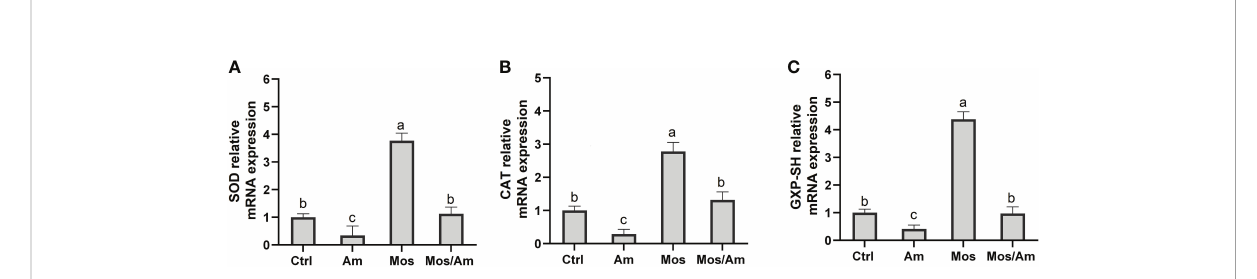
FIGURE 5 Effects of dietary MOS on the mRNA expression of antioxidative genes of the common carp under ammonia stress for 30 days. Values are expressed as mean ± standard error (SE) from triplicate groups. Bars with different letters differ signi fi cantly from those of other groups (P < 0.05). SOD relative mRNA expression (A) , CAT relative mRNA expression (B) , GSH-PX relative mRNA expression (C)